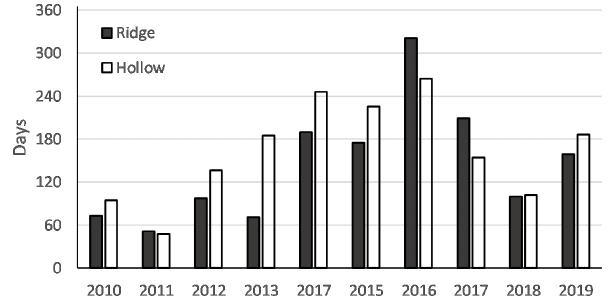
Figure 2. Number of days with hydrometeorological data at Mukhrino field station,